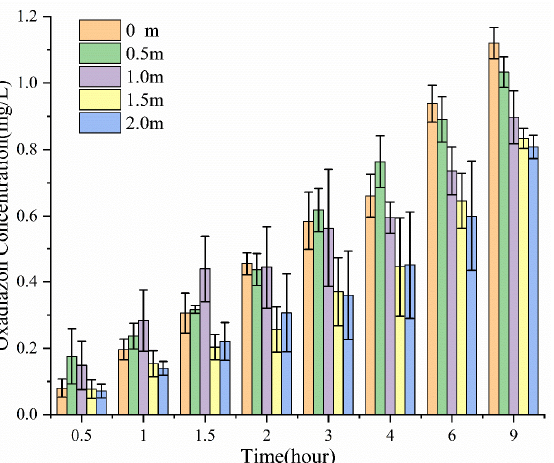
Figure 2. Concentration of oxadiazon in water at different times and different distances from the deposition point of SO containing 10 wt % S409.